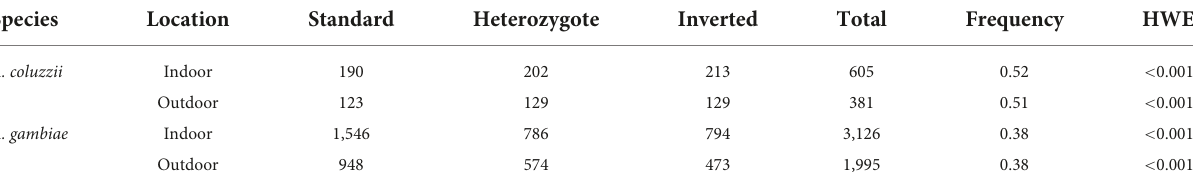
TABLE 1 Summary of mosquito specimens collected and karyotyped in Bangui, Central African Republic.